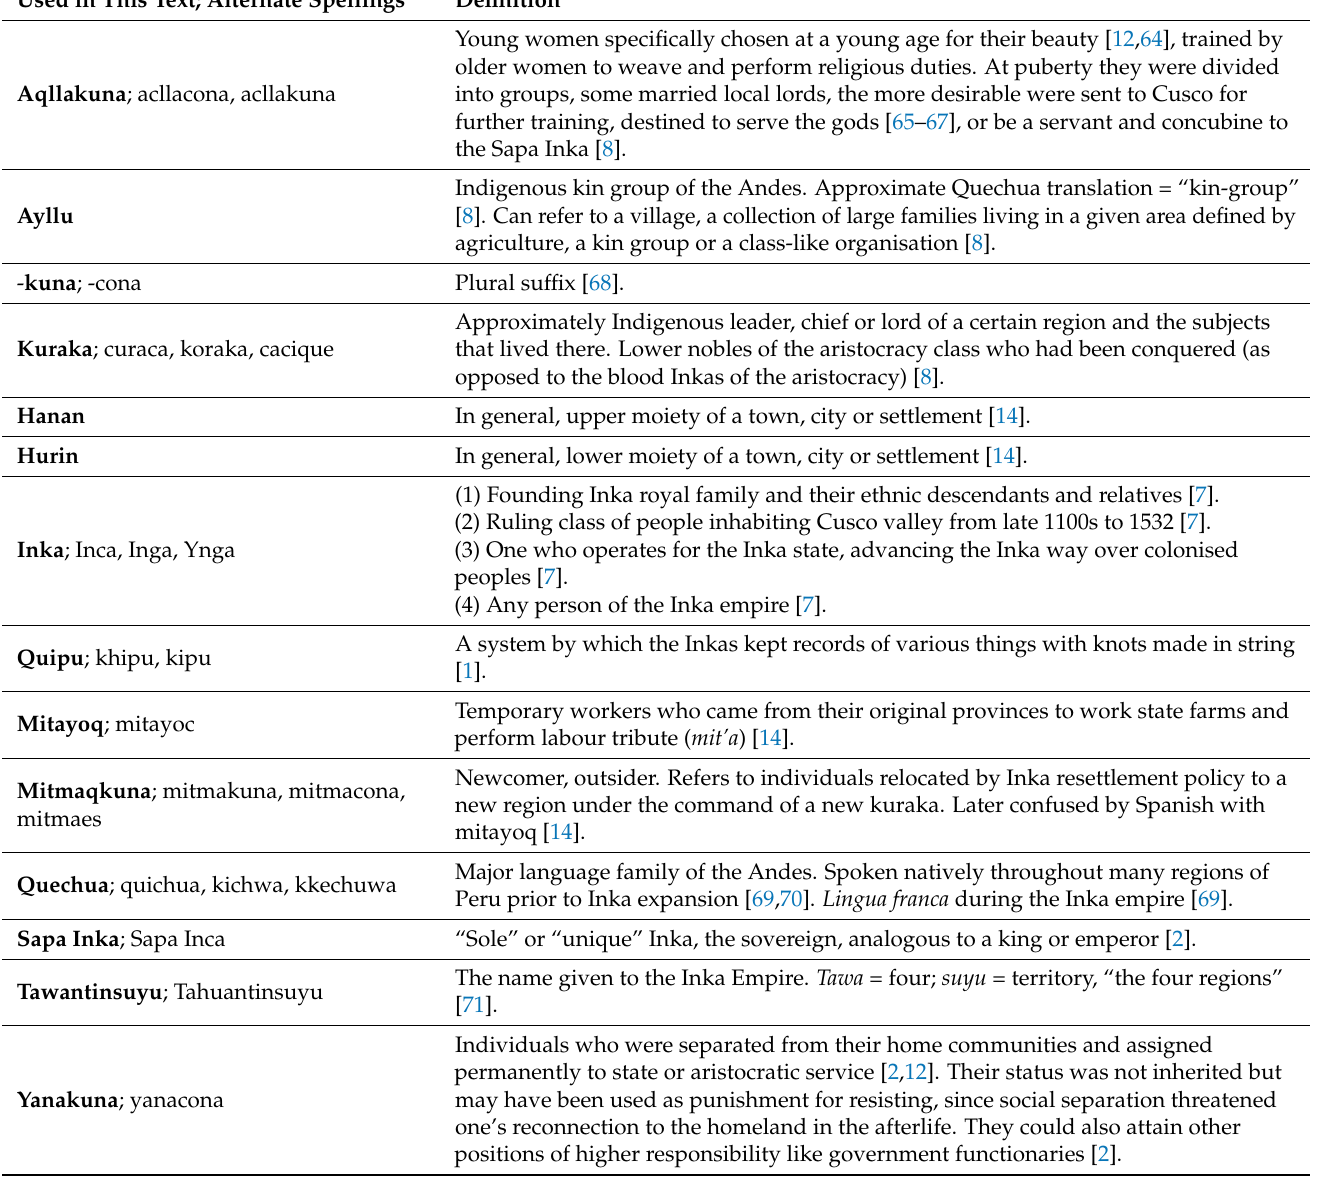
Table A1. Glossary of Inka terms used in the text and alternate spellings that are often